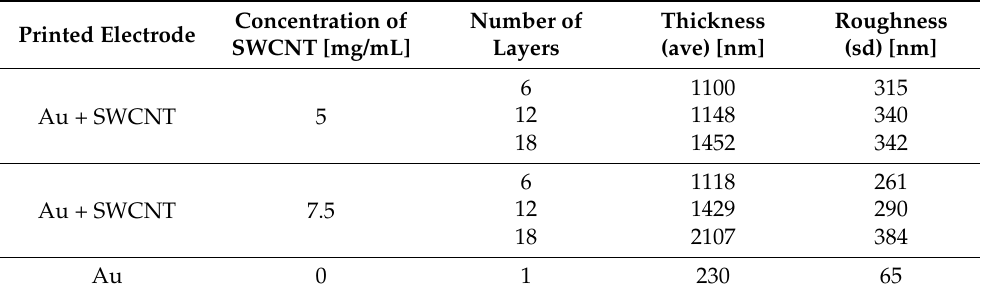
Table 2. Average thickness and roughness of electrodes printed with different combinations of SWCNT concentrations and number of layers and a layer of Au printed. Concentration of Printed Electrode SWCNT [mg/mL]